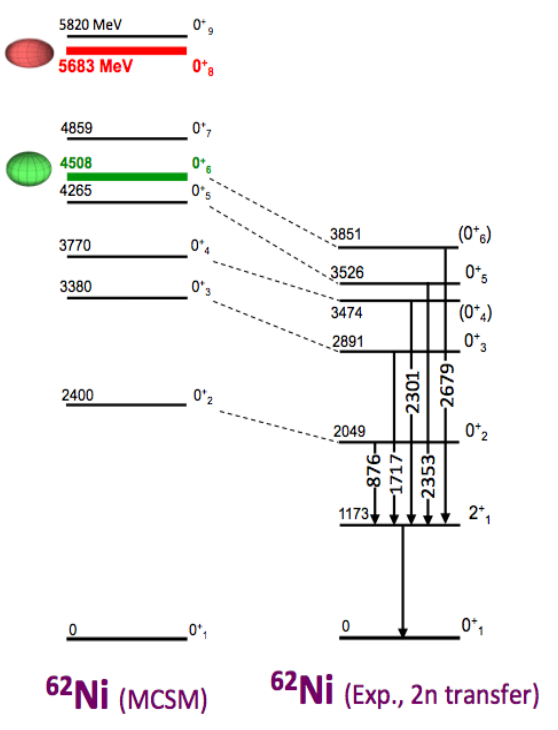
Figure 3. Preliminary comparison between MCSM predictions (left) and experimental data (right) for excited 0 + states in 62 Ni. The experiment was performed with the Nu- Ball array at ALTO IPN-Orsay, employing the 2n-transfer reaction 60 Ni( 18 O, 16 O) 62 Ni, at sub-Coulomb barrier